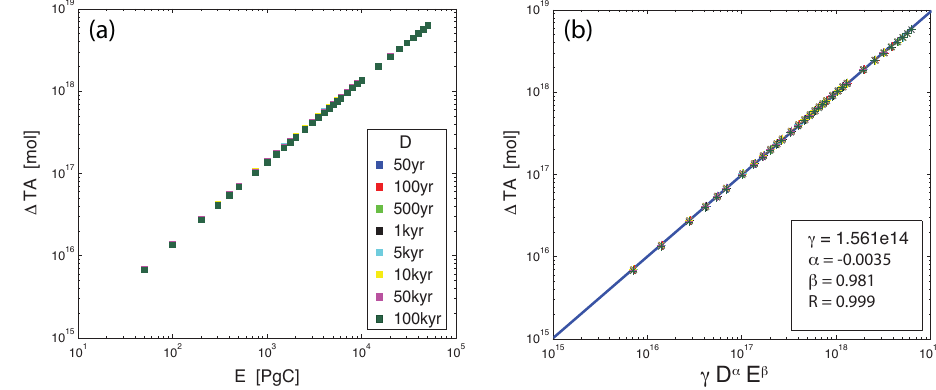
Figure 10. (a) Peak changes in the modern global ocean total alkalinity (TA) as a function of total emission, E , for various durations, D . (b) Multivariable regression results. Solid line indicates a perfect fit to the predicted scaling. The asterisks are each individual